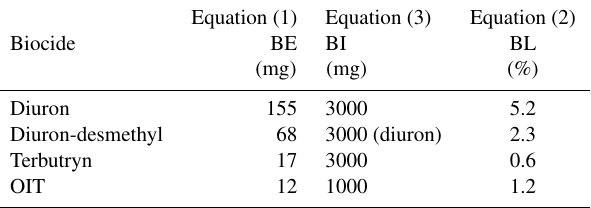
Table 4. Estimated 2-year biocide emission from 10m 2 rooftop fa- cade at house 4 with BE as net biocide emissions, BI initial biocide concentration at facade, and BL biocide leaching